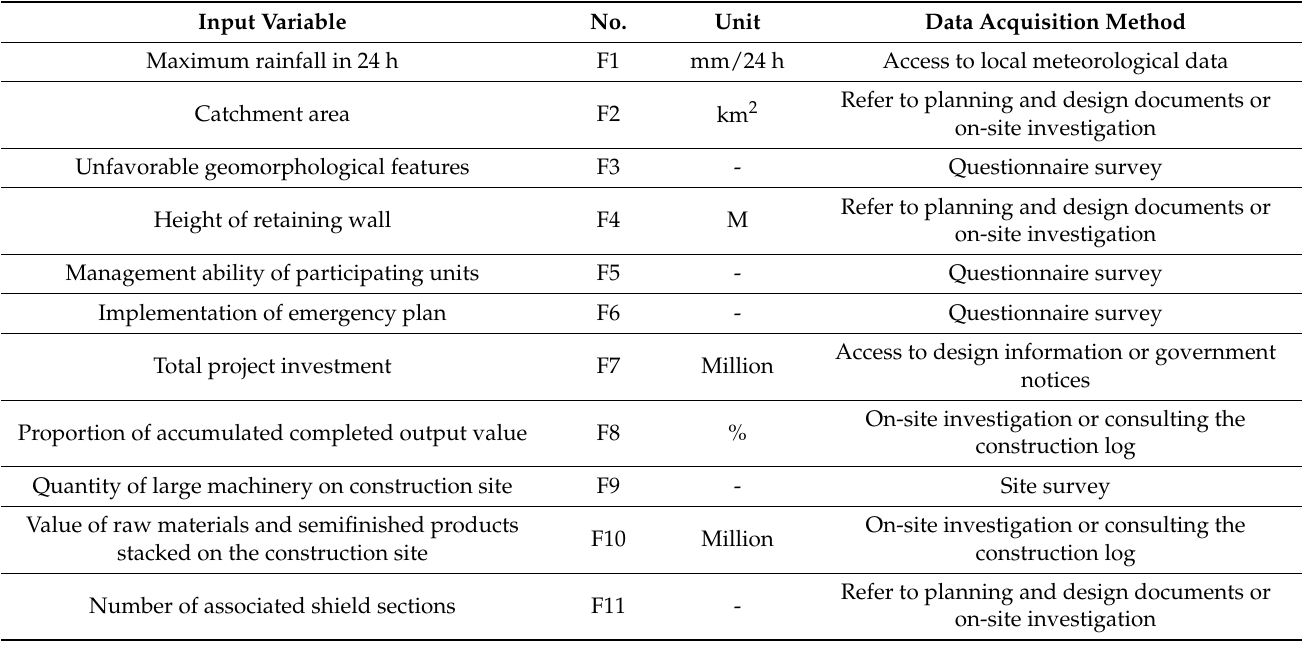
Table 1. System of input variables.